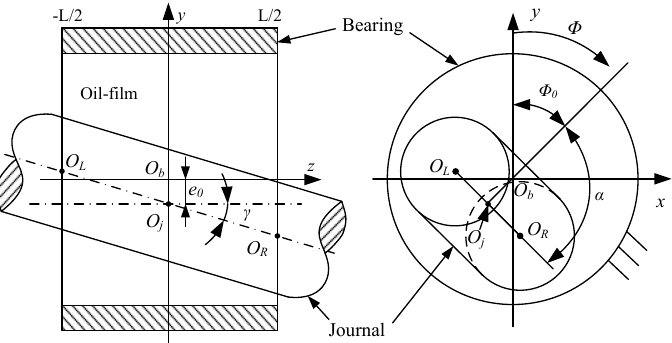
Figure 2. Schematic diagram of a misaligned